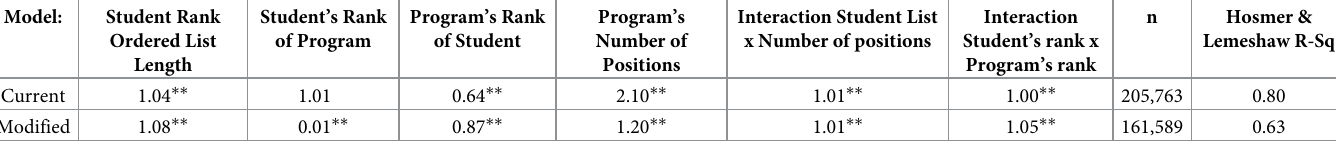
Table 3. Algorithm models—Odds ratios of